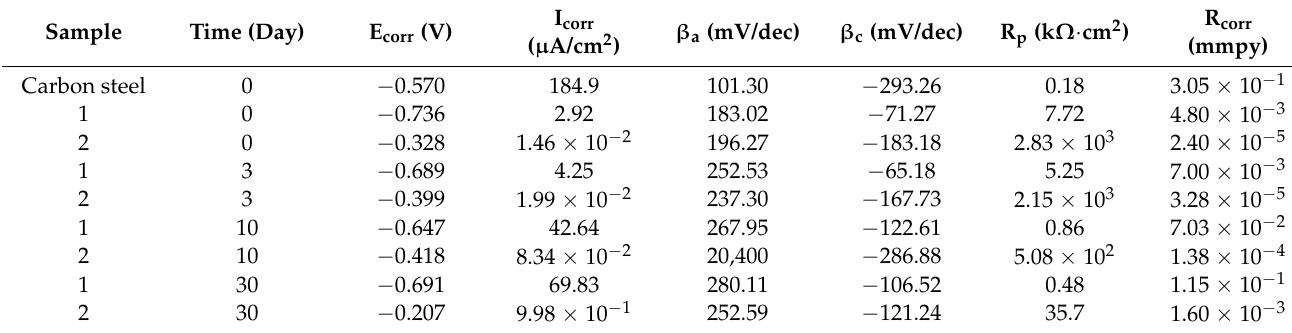
Table 5. Polarization data for waterborne epoxy ‐ styrene ‐ acrylate composite at different time intervals (* 1: conventional core ‐ shell structure, 2: three ‐ layer core ‐ shell structure).